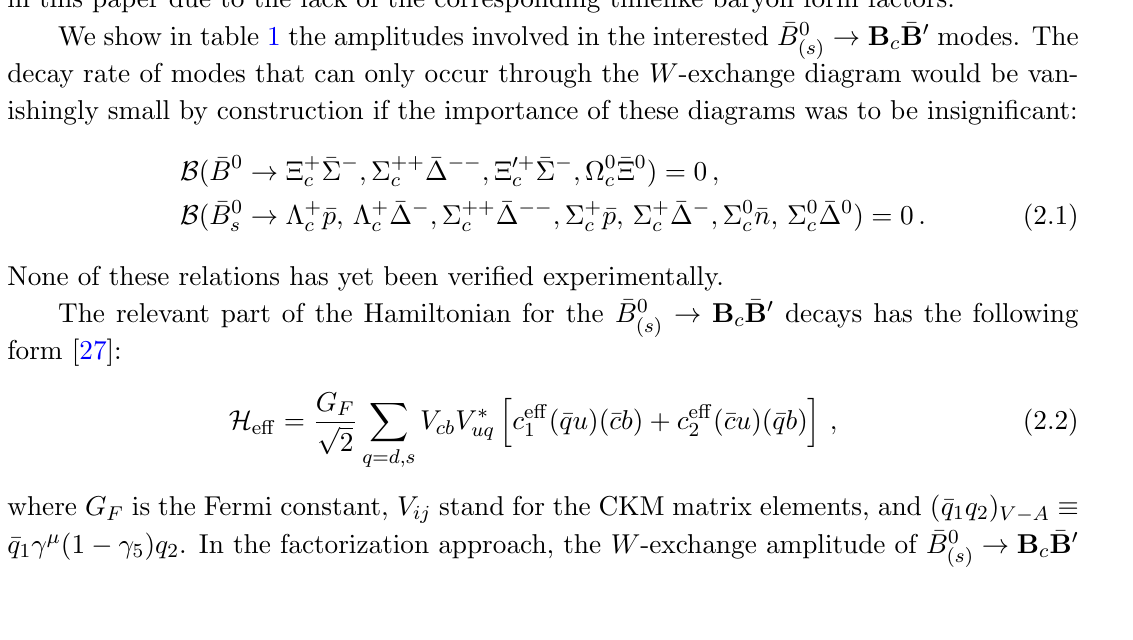
Table 1 . Classi(cid:12)cation for B the W -exchange and W -emission diagrams,